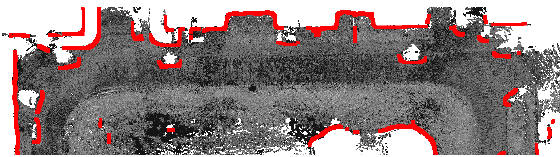
Figure 1. Inaccurate road boundary extracted (highlighted by red color) from low accuracy LiDAR data by employing regular